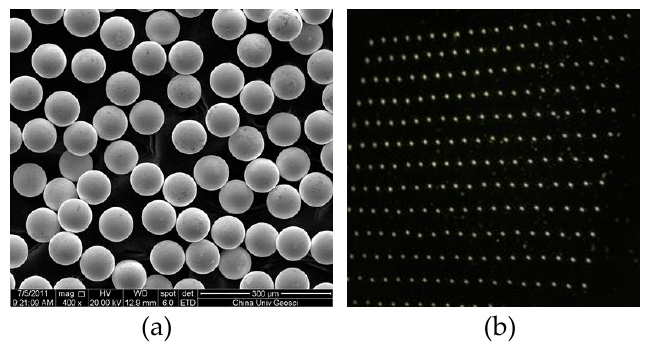
Figure 17. ( a ) Microsolder balls in silicone oil, ( b ) microsolder balls array on stainless steel plate.